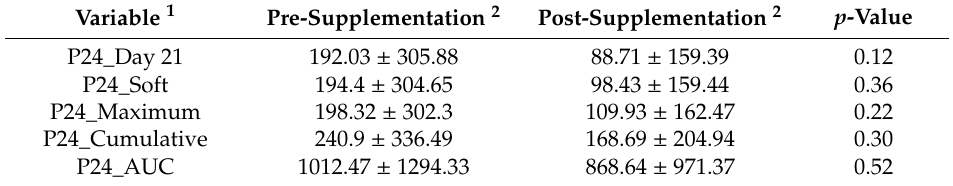
Table 5. HIV replication in cervical biopsies at pre- versus post-vitamin D